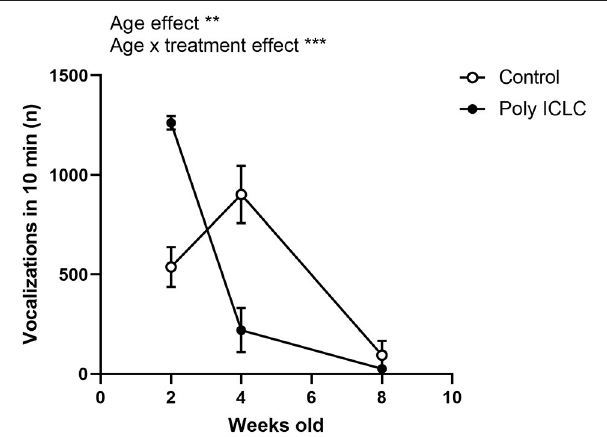
FIGURE 4 | Comparison of the total number of vocalizations in different litters from the same dam. Total number of vocalizations performed by 2, 4, and 8 week old marmosets. The offpring are from one control litter and one poly ICLC litter that were born from consecutive pregnancies. Data are expressed as mean ± SEM and analyzed using Two-Way ANOVA repeated measures with Bonferroni post-hoc . Control n = 2 (females) and Poly IC n = 2 (1 female and 1 male) Significant differences are indicated by ** p < 0.01 and *** p <